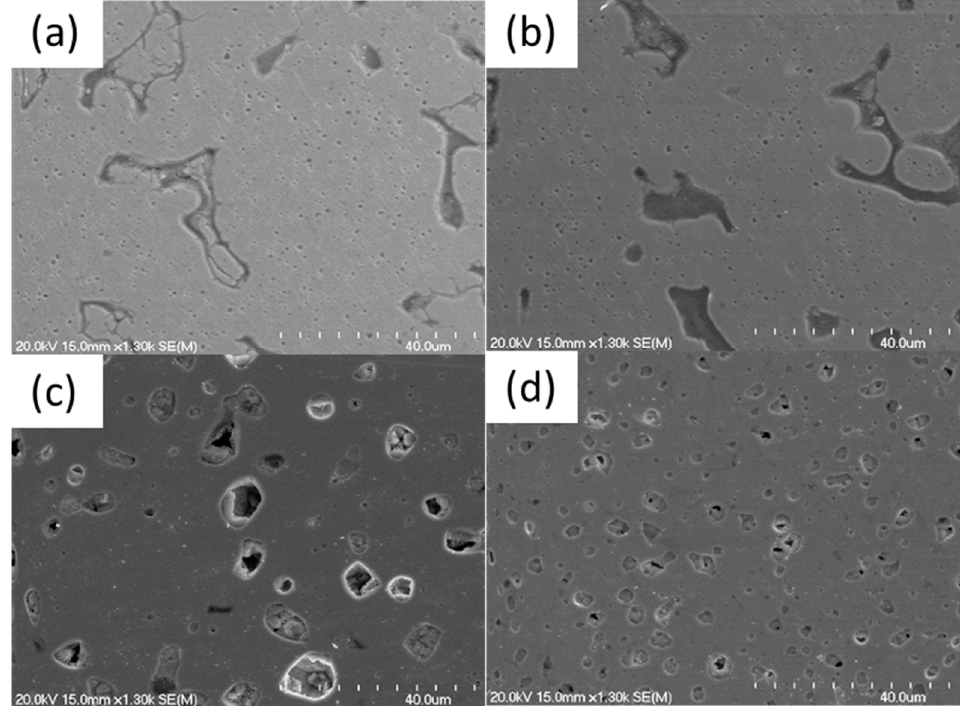
Figure 7. SEM images of the as sintered HEA NiMnFeCu at high magnification. ( a ) At 1000 °C for 1 h (S1), ( b ) at 1000 °C for 2 h (S2), ( c ) at 1050 °C for 1 h (S3), ( d ) at 1050 °C for 2 h (S4).